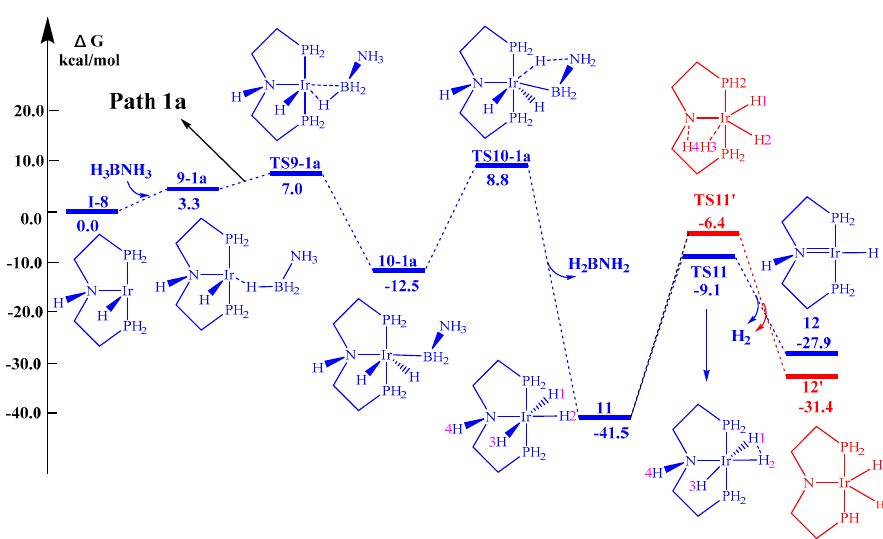
Figure 7. Stepwise reaction potential surface starting from intermediate I-8.